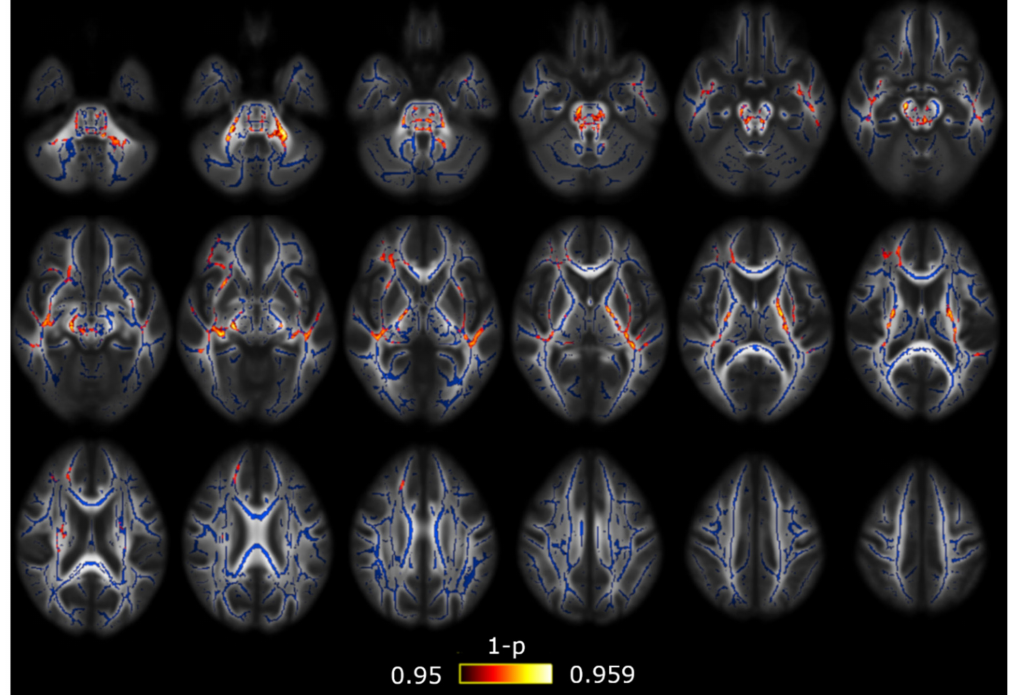
Figure 4. Return-to-origin (RTOP) alterations in patients with EM in comparison with HC. Lower RTOP values were found in EM. The white matter skeleton is shown in blue and voxels with significant di ff erences in red-yellow. The color bar shows the 1-p values (family-wise error